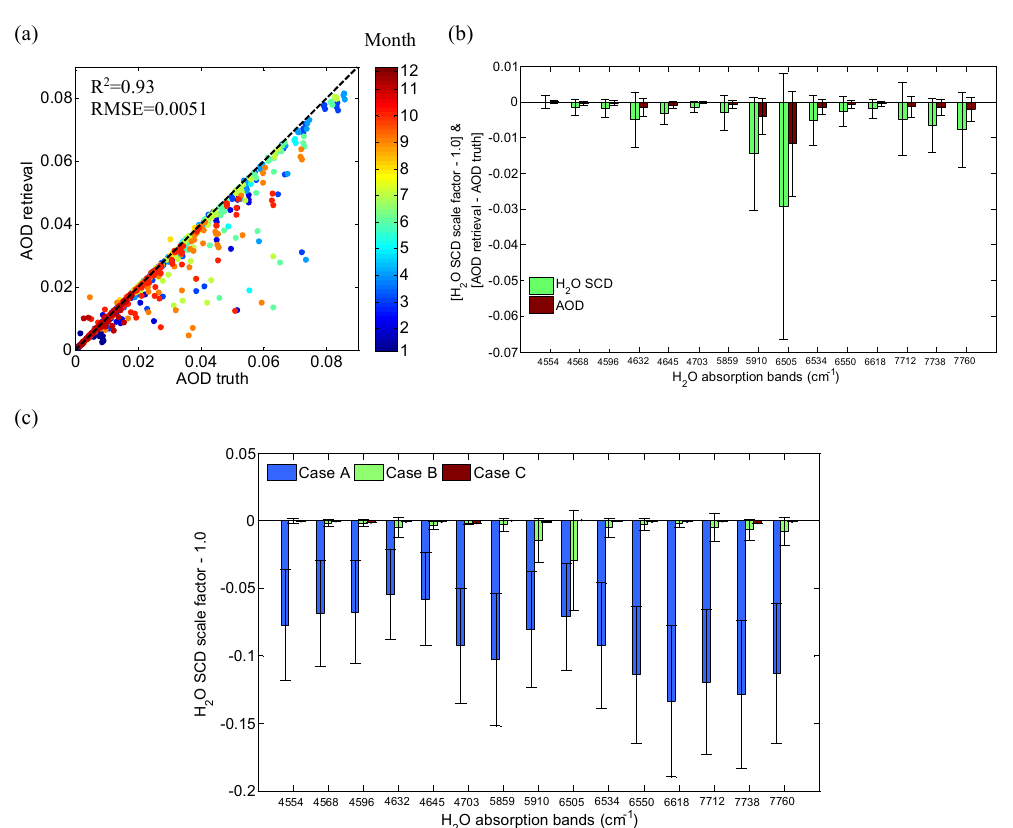
Figure 8. Retrieval of AOD and H 2 O SCD simultaneously based on a realistic numerical simulation study using the 2S-ESS RT model. (a) Scatter plots between true and retrieved AOD from the simultaneous retrieval experiment. The mean and standard deviation of the difference between them are − 0.0018 and 0.0051, respectively. The black dotted line is the one-to-one line; (b) retrieval of AOD and H 2 O SCD scale factors averaged over the 15 H 2 O absorption bands from the simultaneous retrieval experiment; the one sigma error bar is also shown; (c) H 2 O SCD scale factor retrievals from three different cases; in Case A, aerosol scattering is not considered; in Case B, H 2 O and AOD are simultaneously retrieved; in Case C, AOD is perfectly